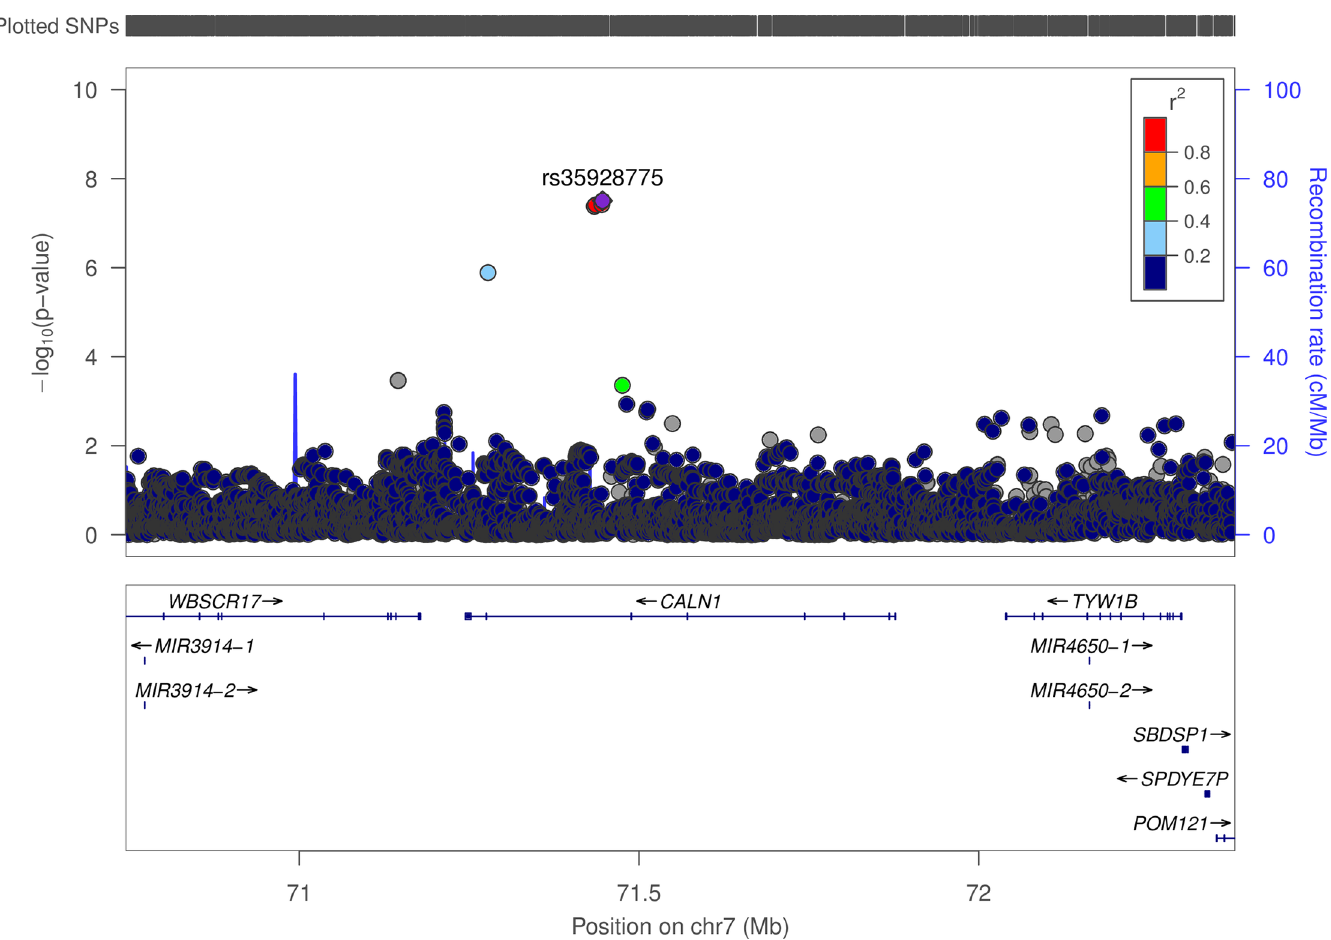
Fig 3. LD structure for variants associated with EPA in and near CALN1